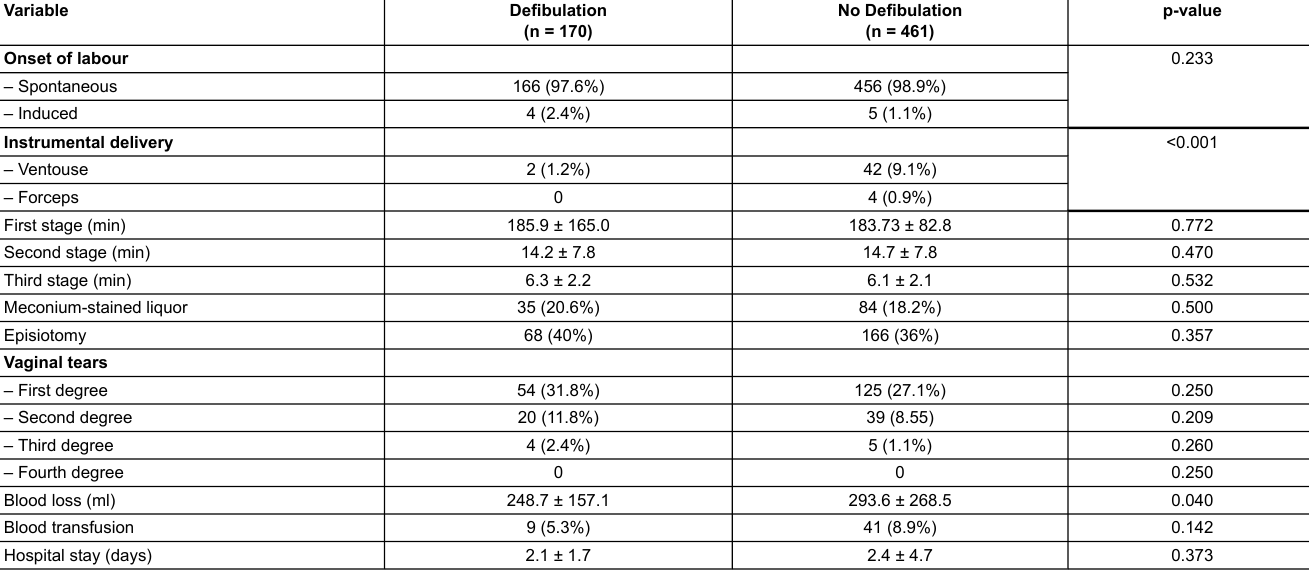
Table 2: Description and comparison of maternal and labour outcomes of the defibulated patients and the control group. Variable